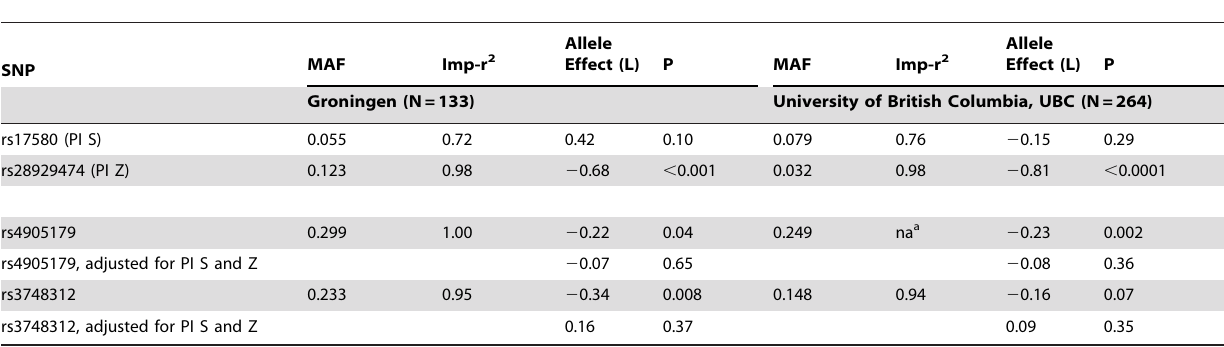
Table 5. Minor allele effects on FEV1 of low-frequent and common SNPs in the SERPINA gene cluster in ever-smokers undergoing lung